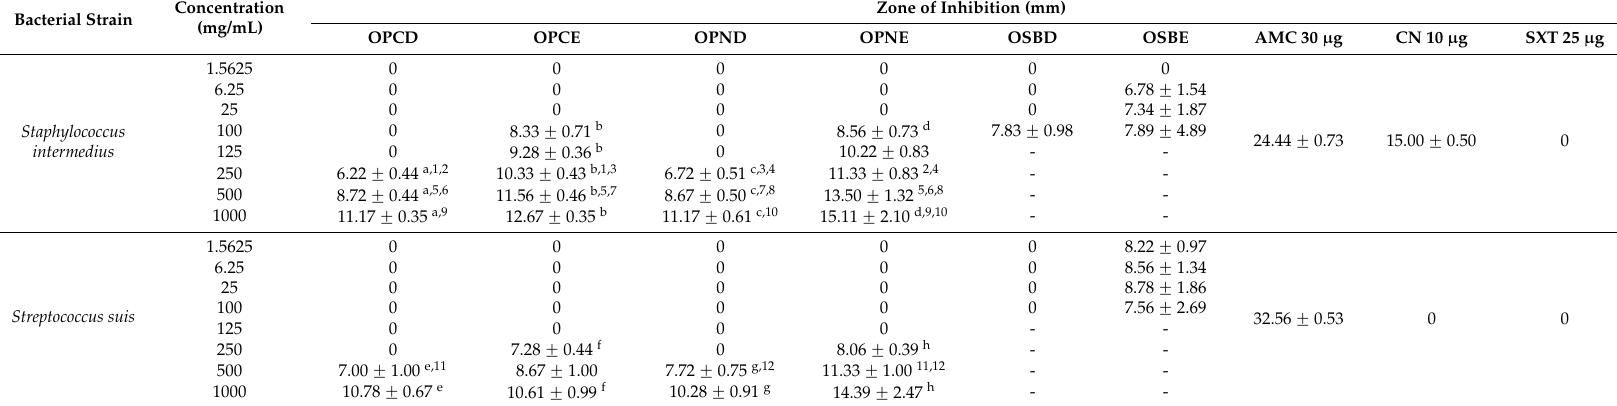
Table 1. Antibacterial activity of Oroxylum indicum fruit and seed extracts against Staphylococcus intermedius and Streptococcus suis determined by the disc diffusion method. Bacterial Strain